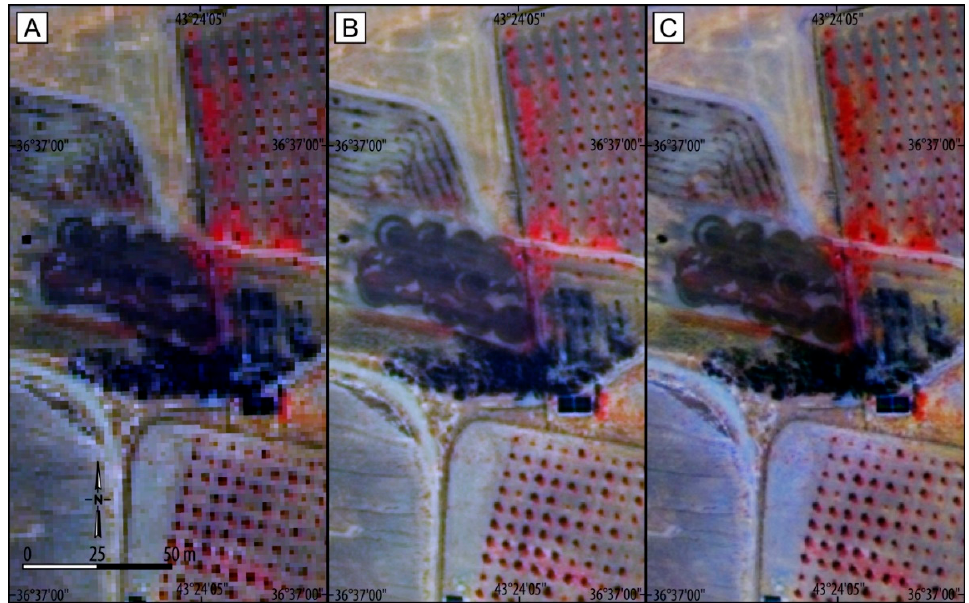
Figure 6. Comparison of a fragment of the source data false color composite (FCC) 158: ( A ) before the integration, ( B ) after the HPF integration, and ( C ) after the IHS integration (ID10300100388F8C00). WorldView ‐ 2 © 2014 DigitalGlobe, Inc., Westminster, Colorado, USA.